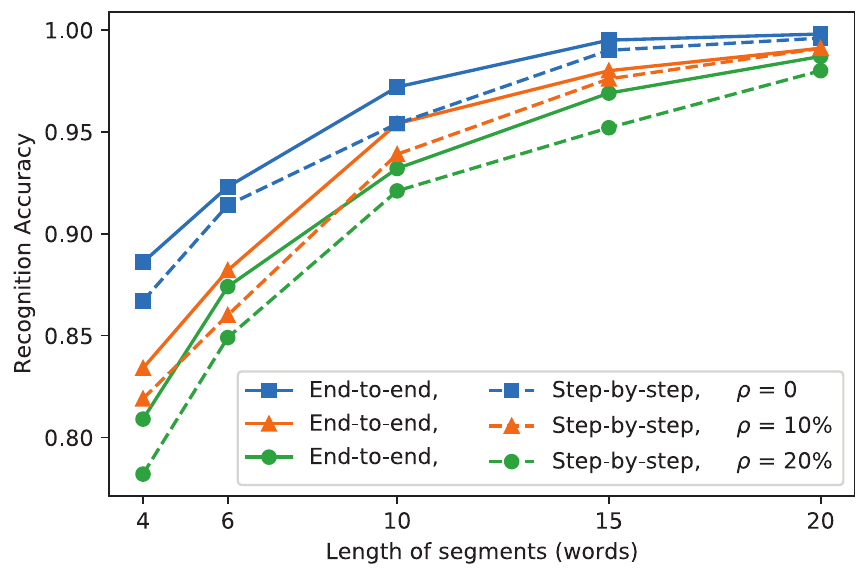
Figure 7. The accuracy of the end-to-end recognition and step-by-step recognition with different segment lengths and radar word